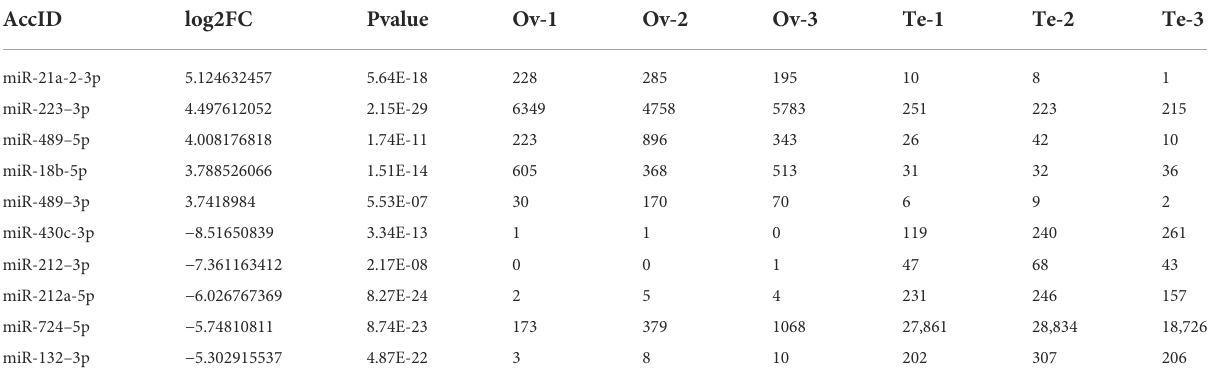
TABLE 1 The expression of DE-miRNAs in the ovary and testis of Collichthys lucidus . Ten DE-miRNAs with largest expression changes were identi fi ed in the ovary and testis.